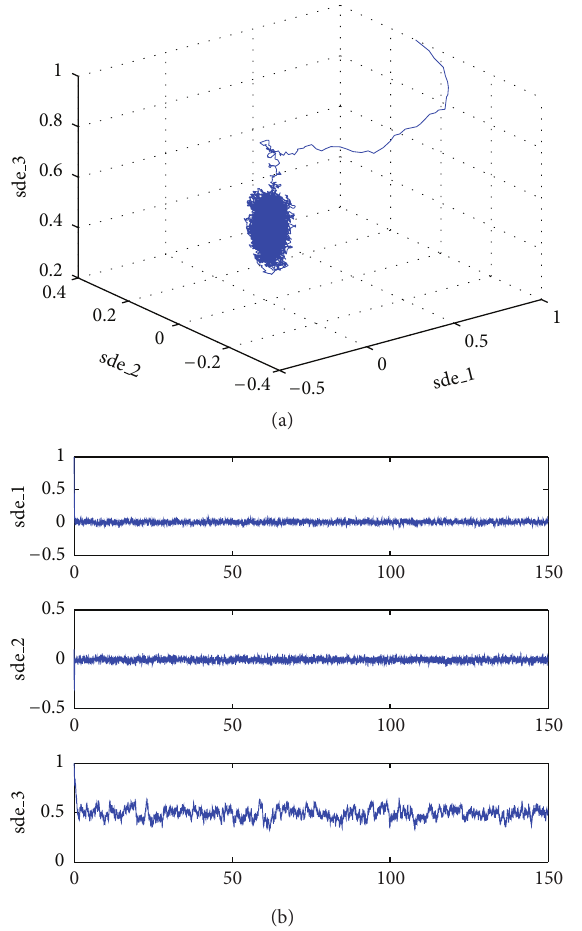
Figure 14: Deterministic system with different linear